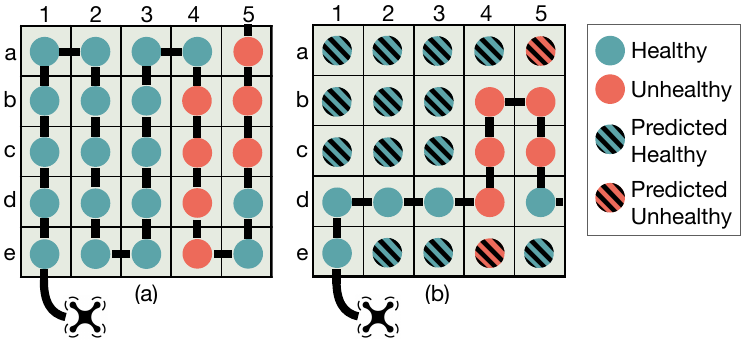
Figure 1. ( a ) Exhaustive scouting of a field wherein UAS visit all zones in a grid; and ( b ) fully autonomous aerial scouting wherein UAS visit a fraction of a field (i.e., eight zones) and predict crop conditions for unvisited